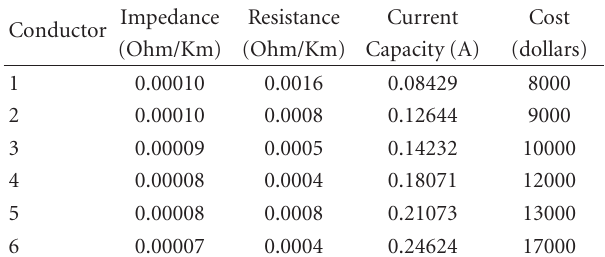
Table 1: Conductor data.